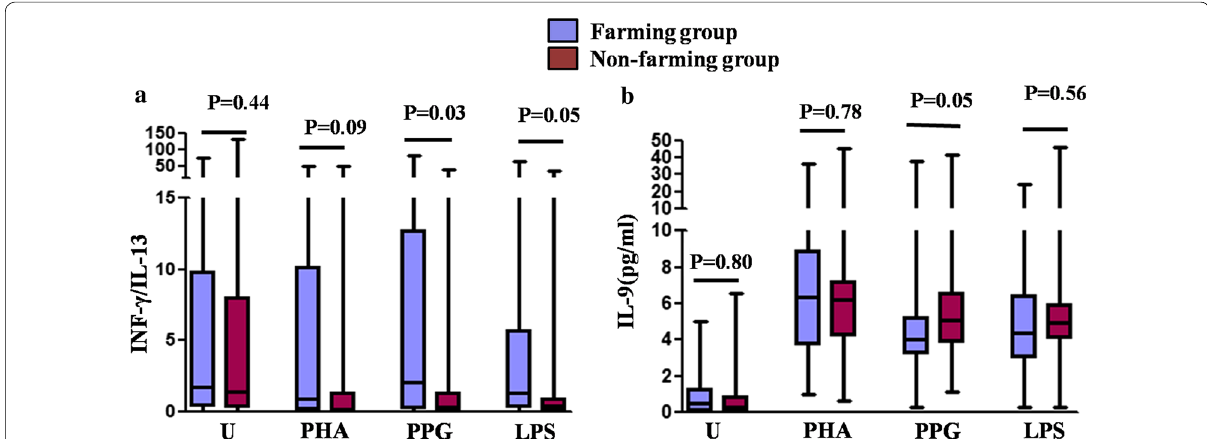
Fig. 2 INF-γ/IL-13 was increased in the farming group after PPG and LPS stimulation, while IL-9 production was reduced after PPG stimulation. Cytokine production by CBMCs was assessed in the farming group (n and LPS challenge. a INF-γ/IL-13 ratio. b IL-9 production. The values are represented as median (25%/75% IQR). Mann–Whitney Rank Sum Test was used to compare the two groups. Statistical significance is indicated by P values <